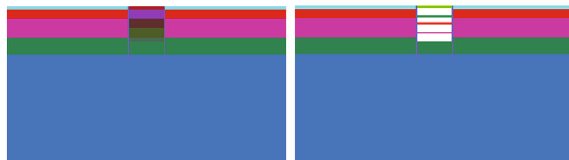
Figure 4: Numerical